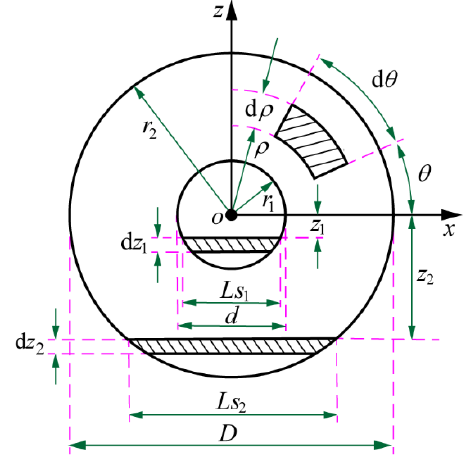
Figure 15. Infinitesimal area d A T (the curved shadow) and d A B (the straight shadow) of the refueling pipe section subjected to torque T and bending moment M , respectively.